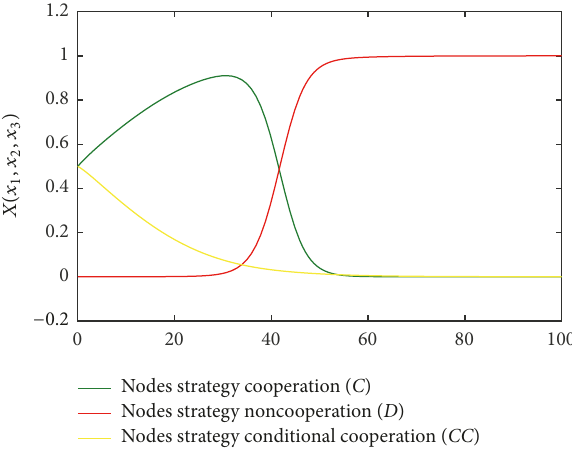
Figure 6: The state of population when 𝑥 = (0.5–0.0001, 0.0001,